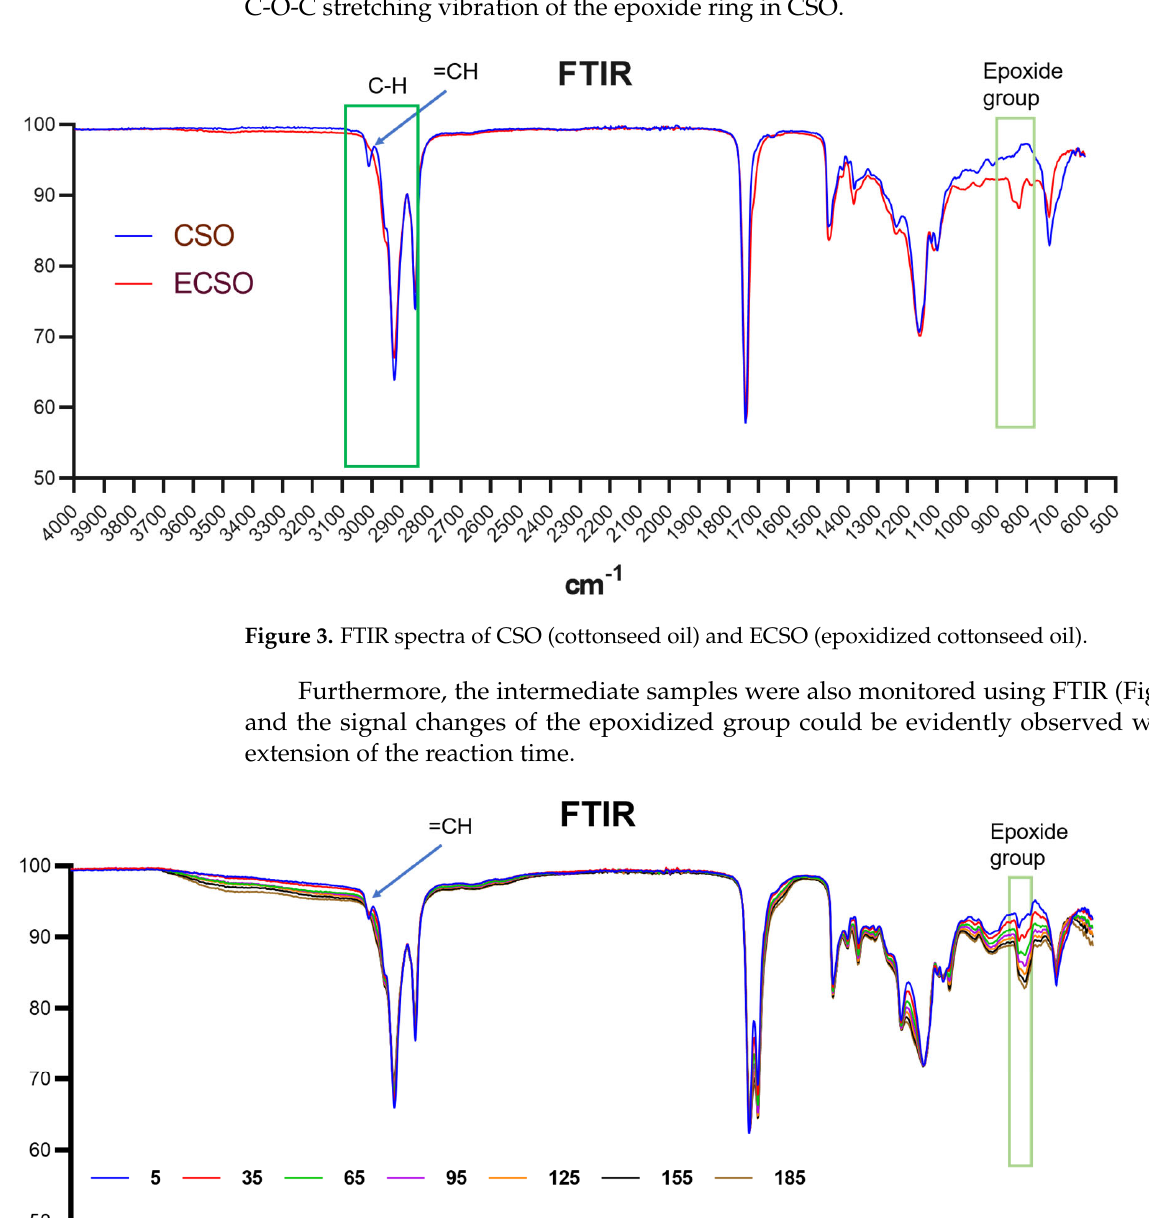
Figure 2. NMR spectra of CSO (cottonseed oil) and ECSO (epoxidized cottonseed oil).